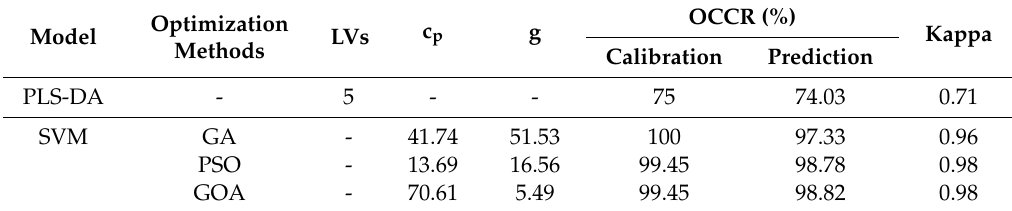
Table 1. Performance of full wavelength models.